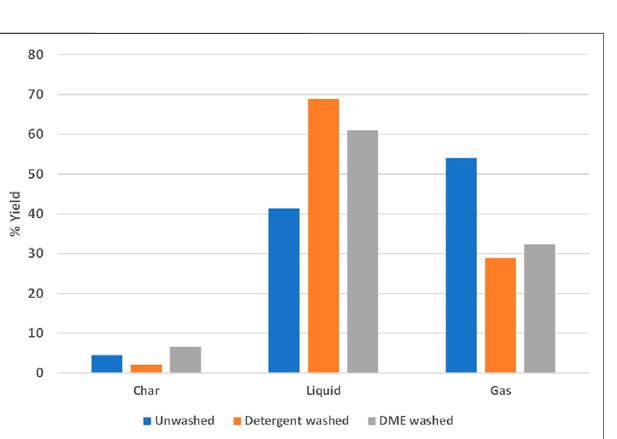
Frontiers in Energy Research |